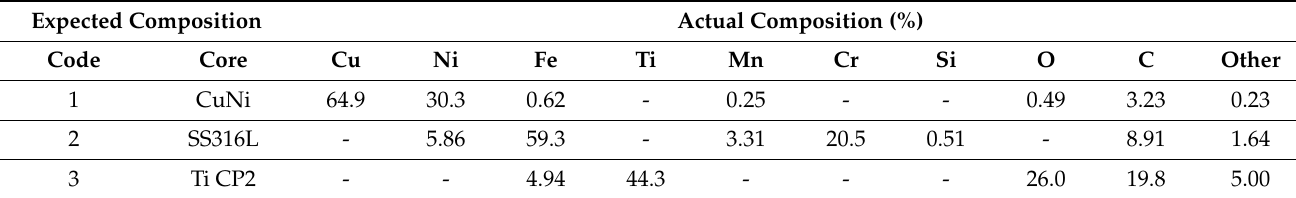
Table 6. Internal surface EDX compositions from box scans of identified contamination zones.